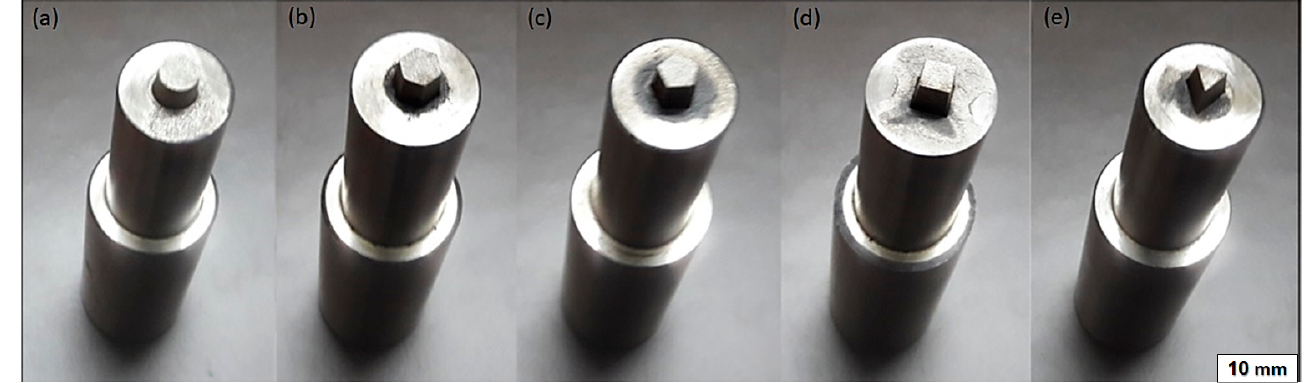
Figure 15. FSW tool pin profiles. ( a ) Cylindrical, ( b ) Hexagon, ( c ) Pentagon, ( d ) square, ( e ) Triangu- lar [133]. Reprinted under the CC BY 4.0 License.